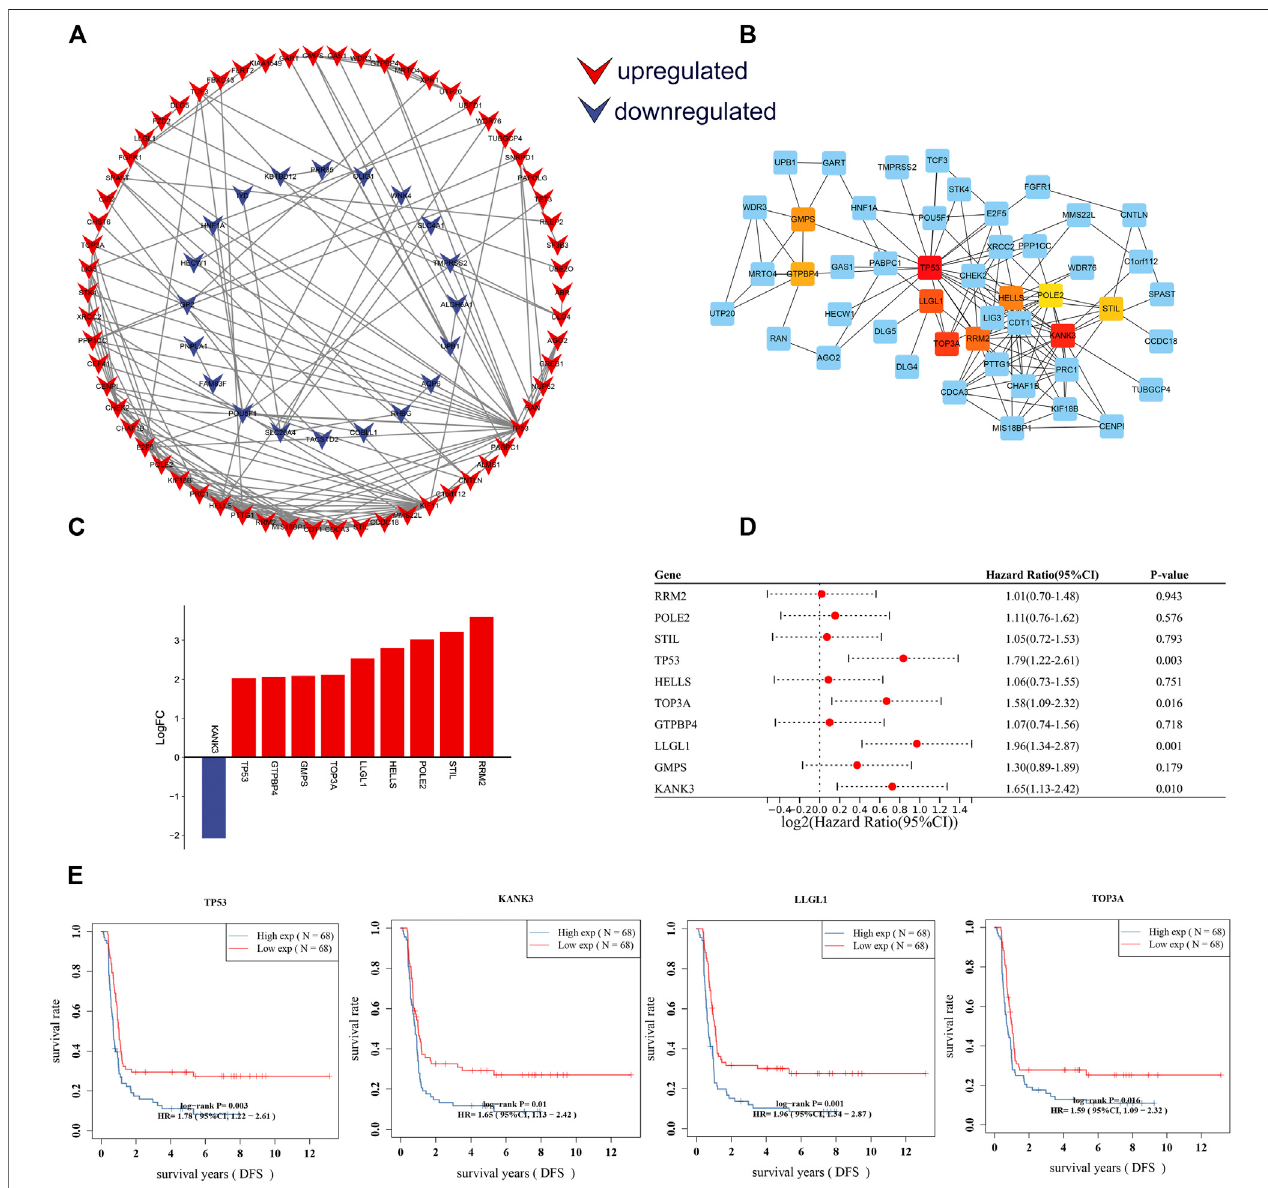
FIGURE 7 | Construction of the PPI network and identi fi cation of DFS-related hub genes. (A) PPI network of DE-mRs in the ceRNA network. (B) The PPI network for top 10 hub genes identi fi ed by cytoHubba. (C) Column chart of expression changes of the top 10 hub genes. Red column indicate up-regulated ( X -axis > 0) genes, bluecolumnindicatedown-regulated( X -axis < 0)genes. (D) ForestplotshowingtheprognosticassociationsofhubgenesinCoxregressionanalysis. (E) Survivalcurves of four hub-genes that are signi fi cantly related to the prognosis of Wilms tumor patients. The horizontal axis shows the follow-up time in years, and the vertical axis shows the probability of disease-free survival. DFS: disease-free